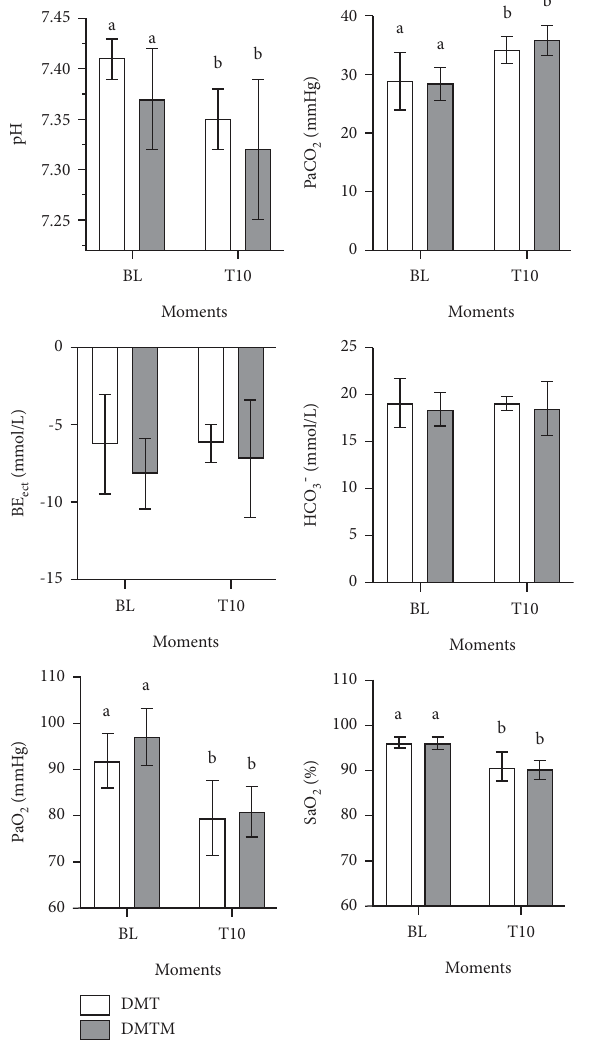
Figure 9: Values of arterial pH, arterial carbon dioxide, and oxygen tensions (PaCO 2 and PaO 2 , respectively), arterial oxygen saturation (SaO 2 ), excess/defcit of bases (BE), and bicarbonate (HCO3 − ), in 18 cats sedated with the association dexmedetomidine (7.5ug/kg) and methadone (0.3mg/kg) (DMT, n � 9) or dexmedetomidine (5ug/kg), methadone (0.3mg/kg), and midazolam (0.3mg/kg) (DMTM, n � 9), both by the intramuscular route. Values are presented as mean ± standard deviation. a, b: diferent lowercase letters indicate a signifcant diference between moments within the same group according to the Tukey test ( p < 0 . 05).